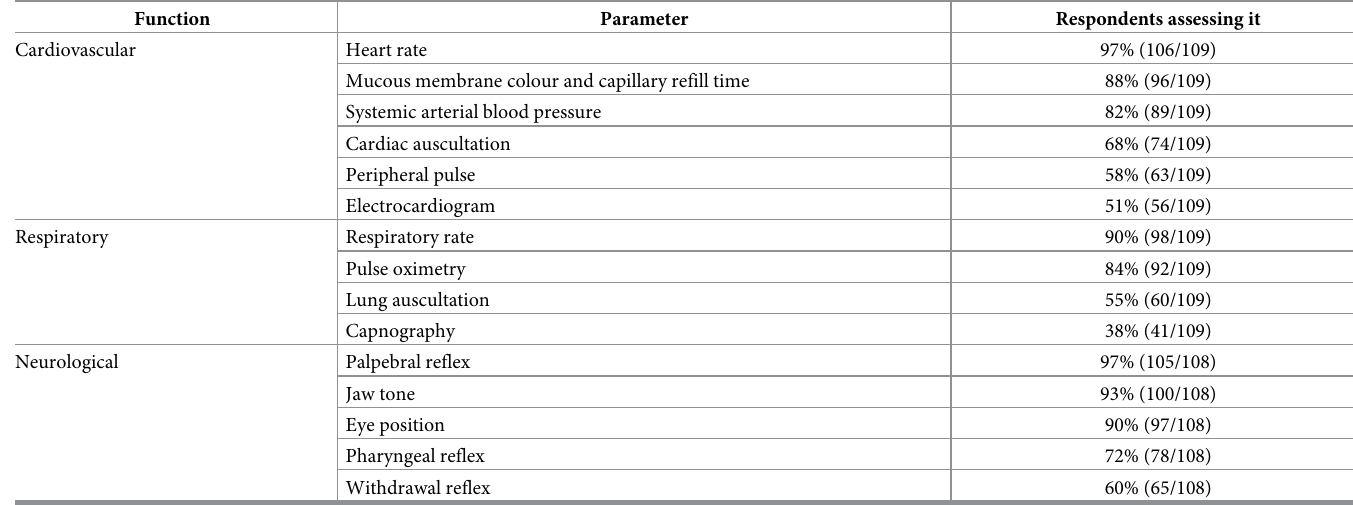
Table 7. Parameters assessed to monitor cardiovascular, respiratory and neurological functions by English-speaking veterinarians responding to the survey. Function